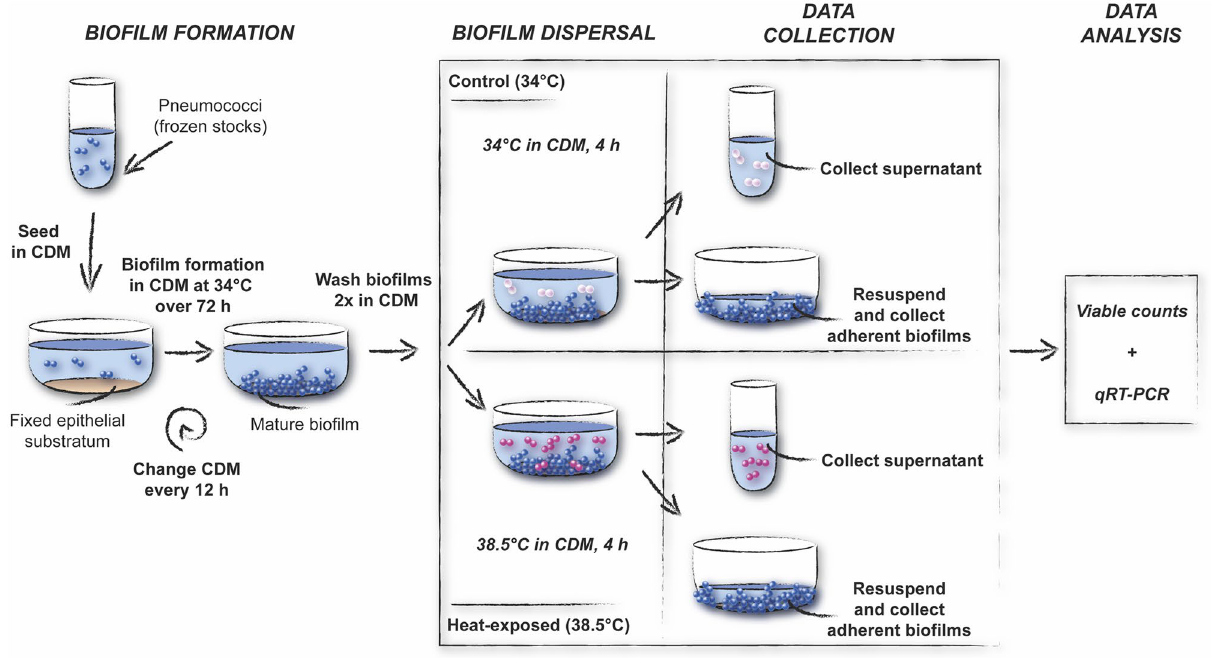
Figure 1. Schematic overview of the model system used in this study. Biofilms were formed in flat bottom wells over 72 h in CDM at 34 °C, with change of medium every 12 h. Biofilms were washed twice in CDM and then incubated in fresh medium at 34 °C (control; upper panel) or at 38.5 °C (lower panel) for 4 h. Supernatants containing released bacteria from control (34 °C) or heat-exposed (38.5 °C) biofilms were then collected